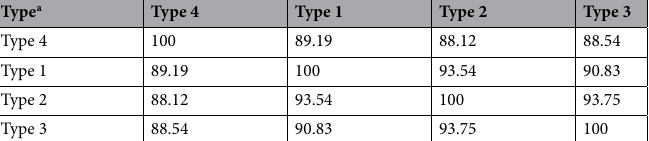
Table 3. Percentage amino acid sequence identity of wzi types. a Type 1 = AB5075-UW (ABUW_2898